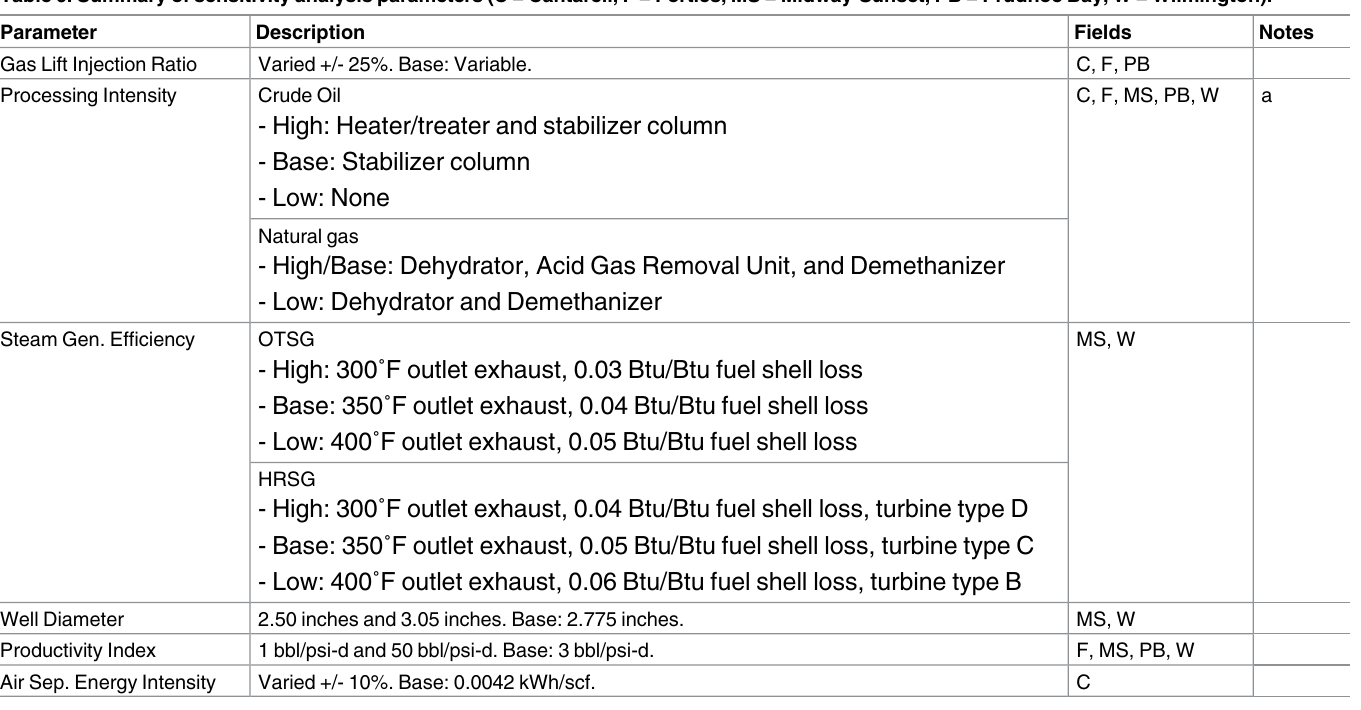
a For Prudhoe Bay processing sensitivity analysis is conducted with crude oil and associated gas processing varied independently. The low-intensity natural gas processing scheme for Prudhoe Bay consists only of the